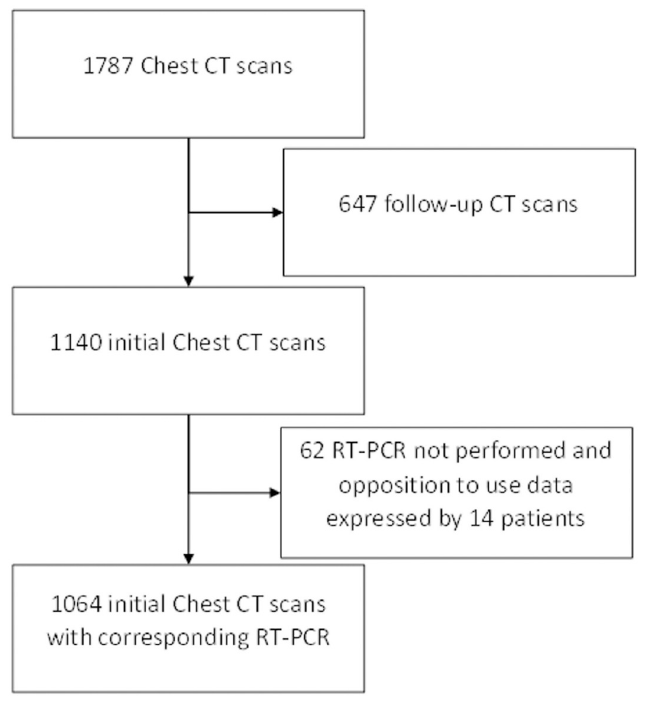
Fig 1. Study flow